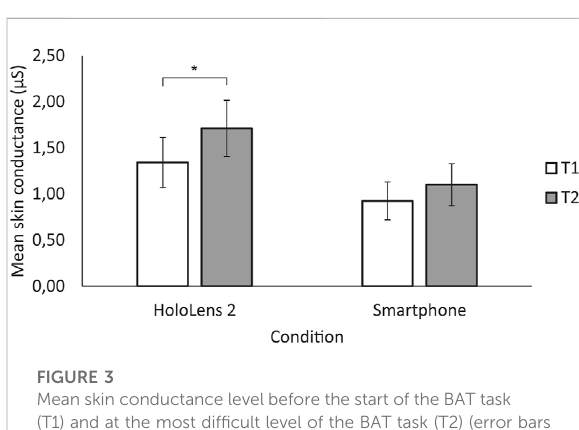
FIGURE 3 Mean skin conductance level before the start of the BAT task (T1) and at the most dif fi cult level of the BAT task (T2) (error bars represent the standard error of the mean). * marks a signi fi cant difference at p < 0.05 in the HoloLens 2